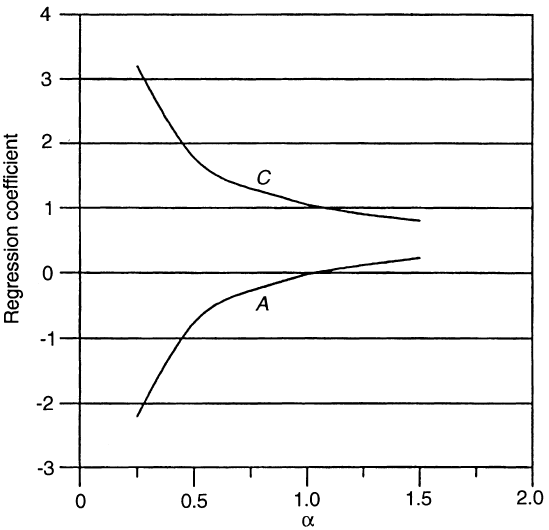
Fig. 4. Linear regression coe(cid:129)cients describing the relationship between R 0 exp and R 0 th values for di(cid:128)erent